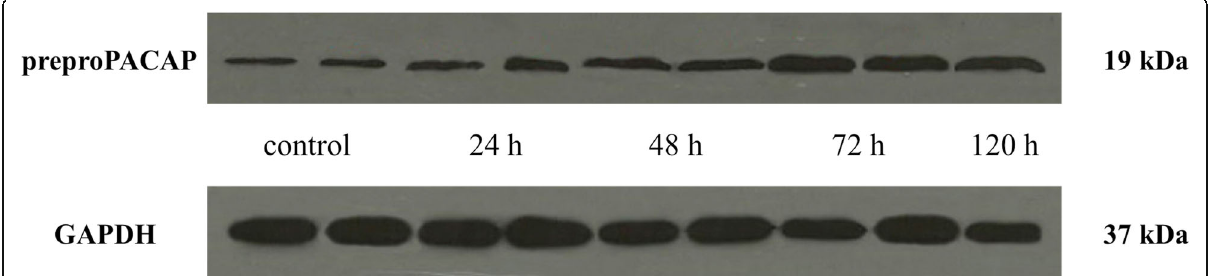
Fig. 2 Western blot of preproPACAP and GAPDH expression in the